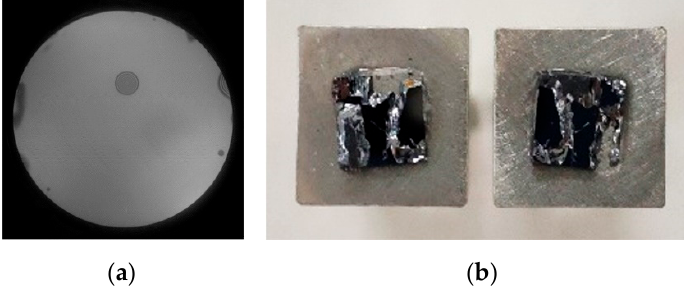
Figure 9. The sample is prepared by (150 W, 100 sccm, 120 s) plasma. ( a ) Infrared image after annealing and ( b ) fracture image after tensile pulling test.